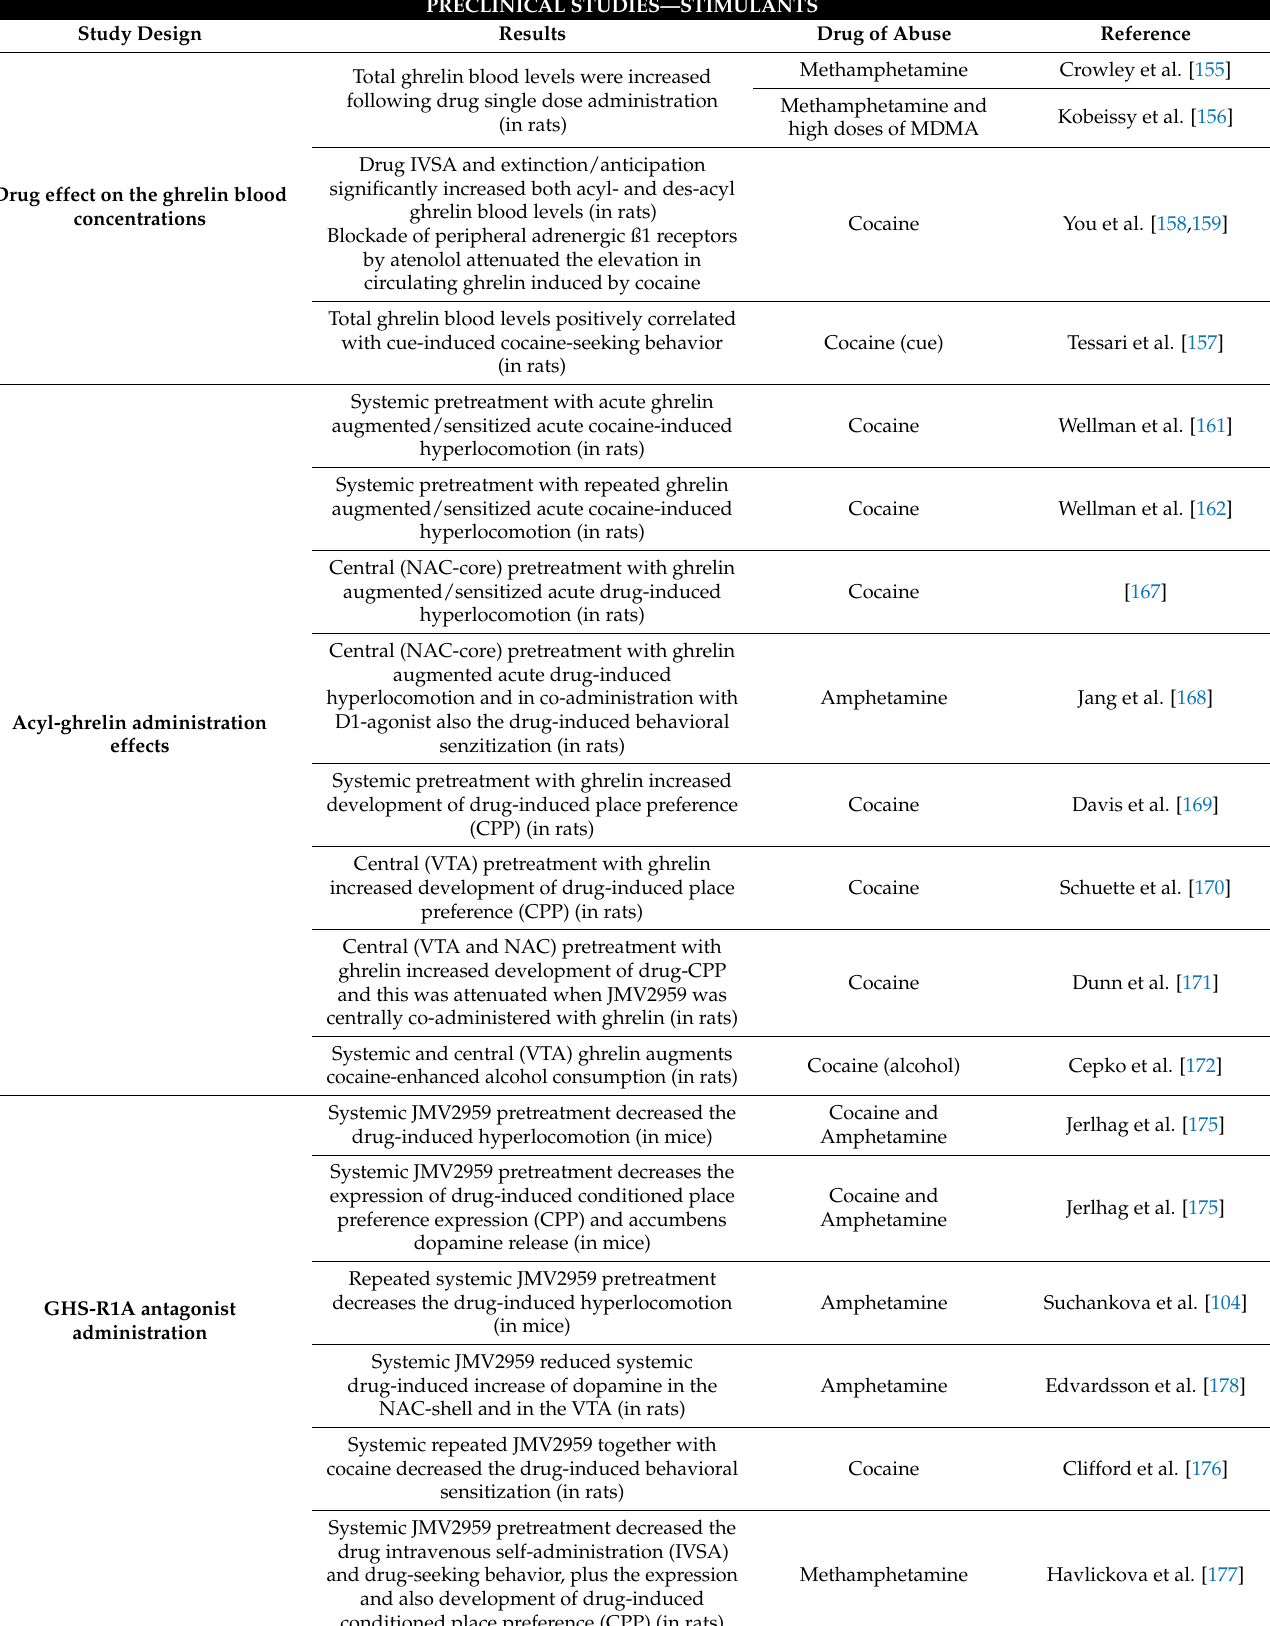
Table 2. Ghrelin/GHS-R1As and stimulants—preclinical and clinical studies